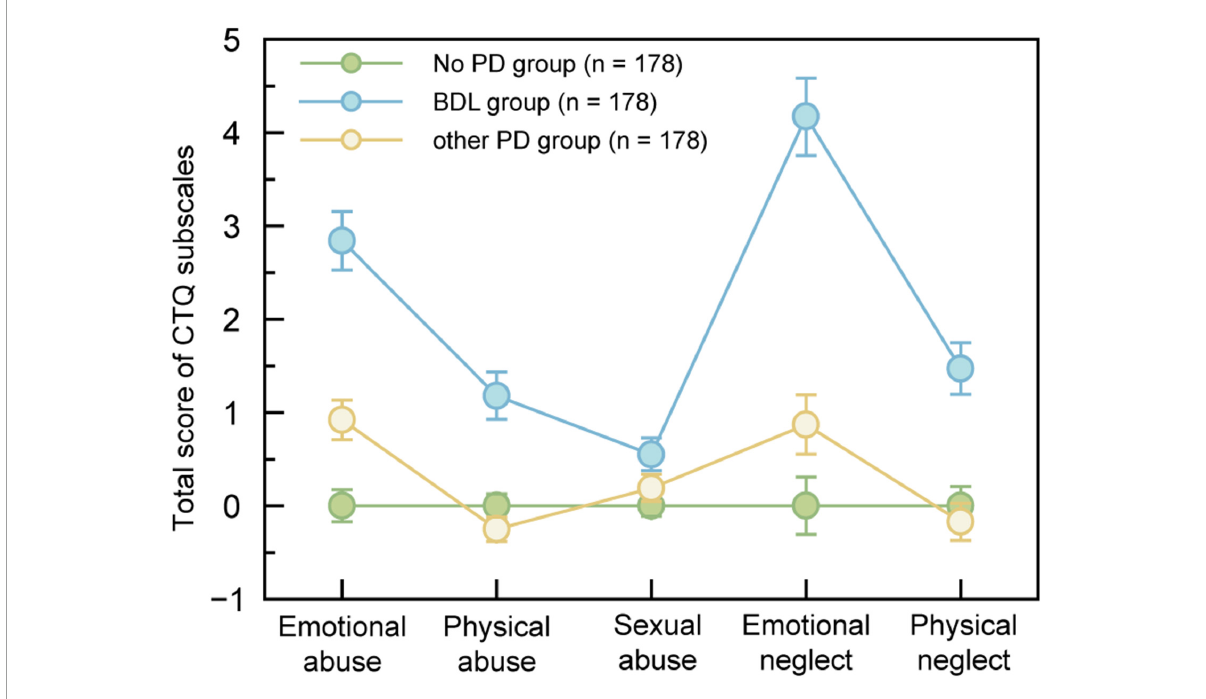
FIGURE3 Childhood trauma profile by different PD groups. Marginal means from mixed models were standardized with control means (SDs) to convert to z-score. Error bars denote SEMs within groups.